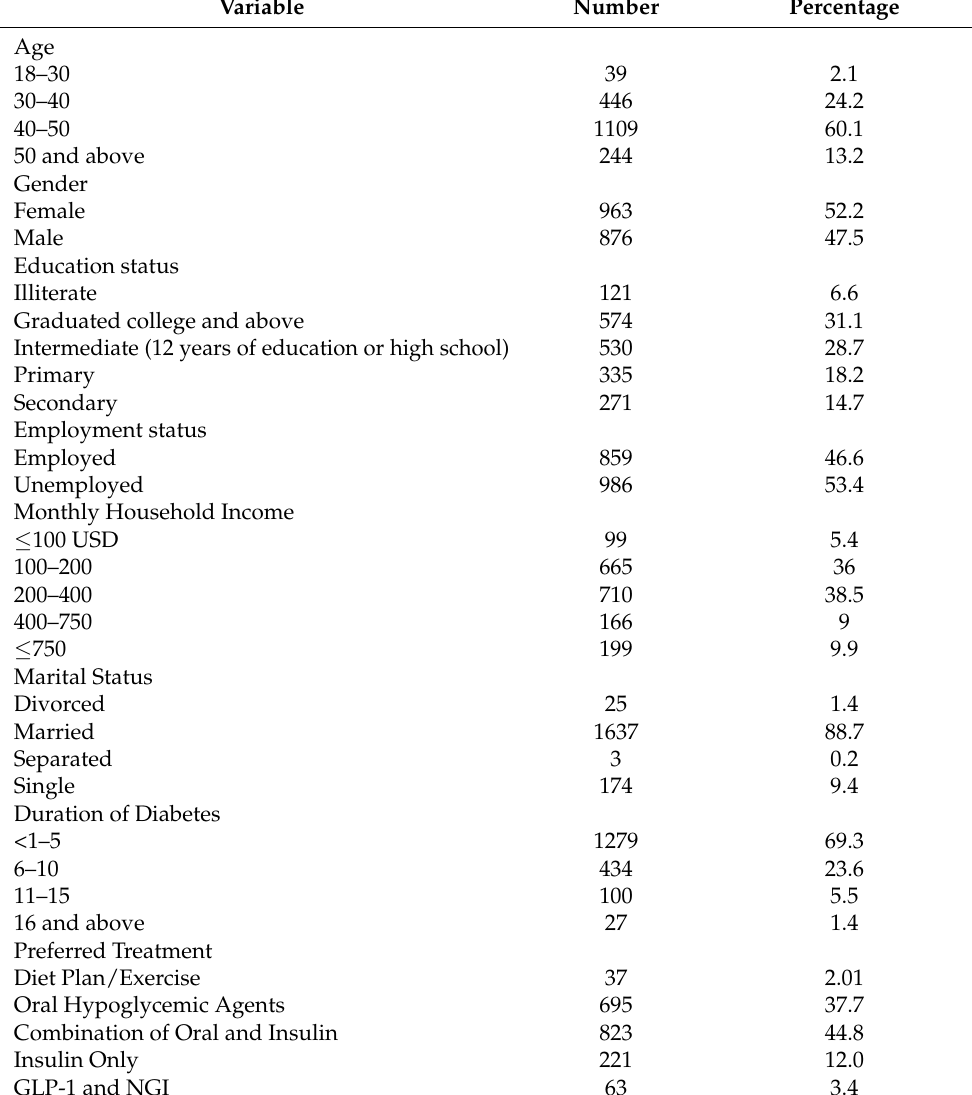
Table 1. Distribution of socio-demographic and clinical